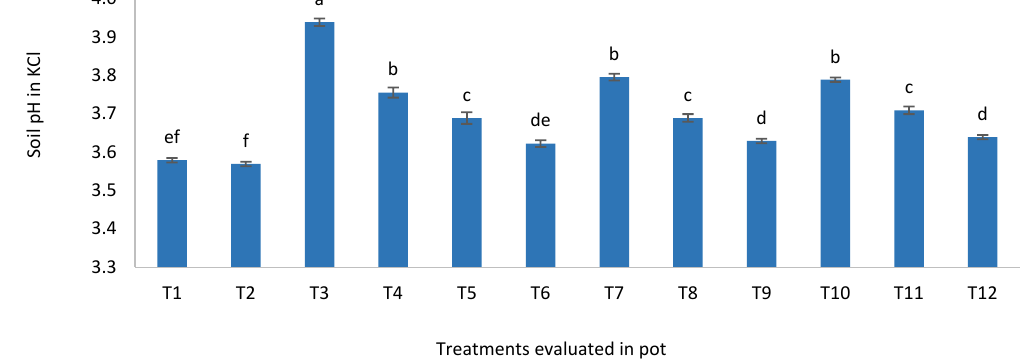
Figure 8. Effects of treatments on soil pH in KCl. Different letters indicate significant difference between means using Tukey’s HSD (Honestly Significant Difference) test at p ≤ 0.05. The error bars are the ± standard error of triplicates.